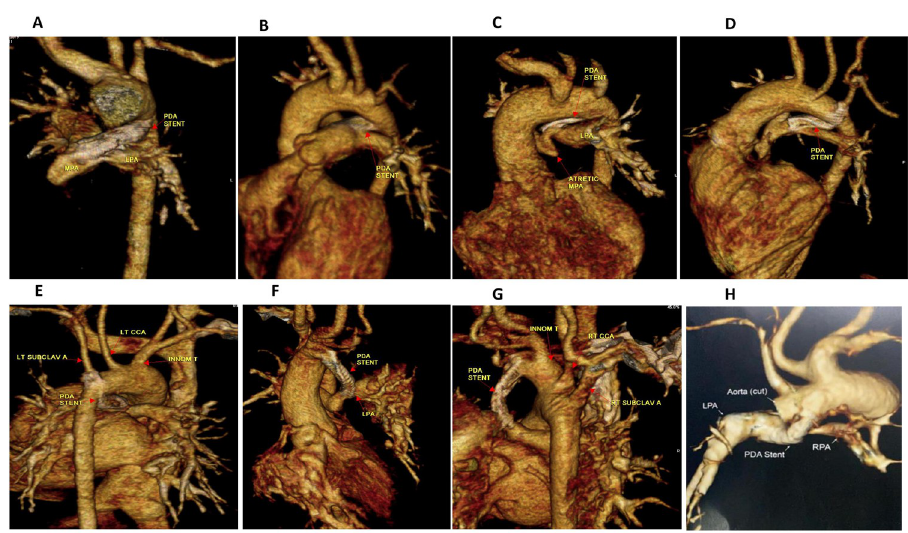
Fig 2. Multidetector computed tomography with 3D volume rendering showing PDA stents in different PDA origins. A-B: PDA from the proximal descending aorta, C: PDA from undersurface of aortic arch, D-E : PDA from opposite the origin of left subclavian artery, F-G; PDA arises opposite the innominate (Brachiocephalic trunk), H: PDA stent is seen protruded into the LPA causing jailing of RPA and associated with RPA origin stenosis. PDA: patent ductus arteriosus, MPA: Mean pulmonary artery, LPA: right pulmonary artery, LPA left pulmonary artery, CCA: common carotid artery.